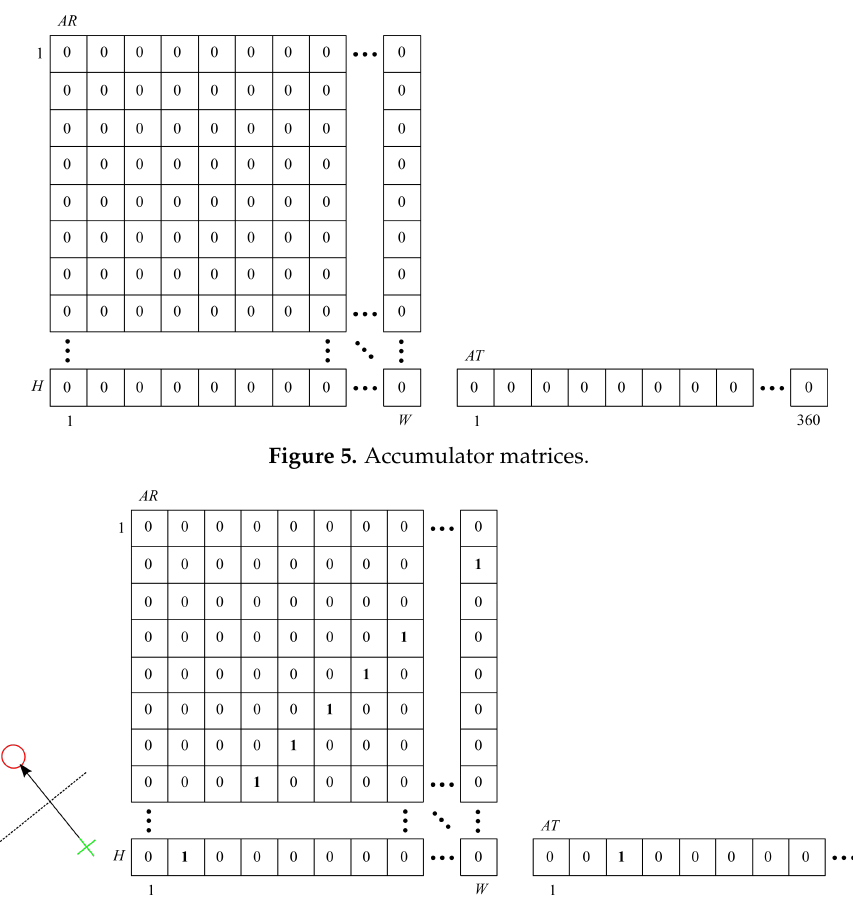
Figure 6. AR and AT after taking into account the “votes” of one pair of corresponding points.